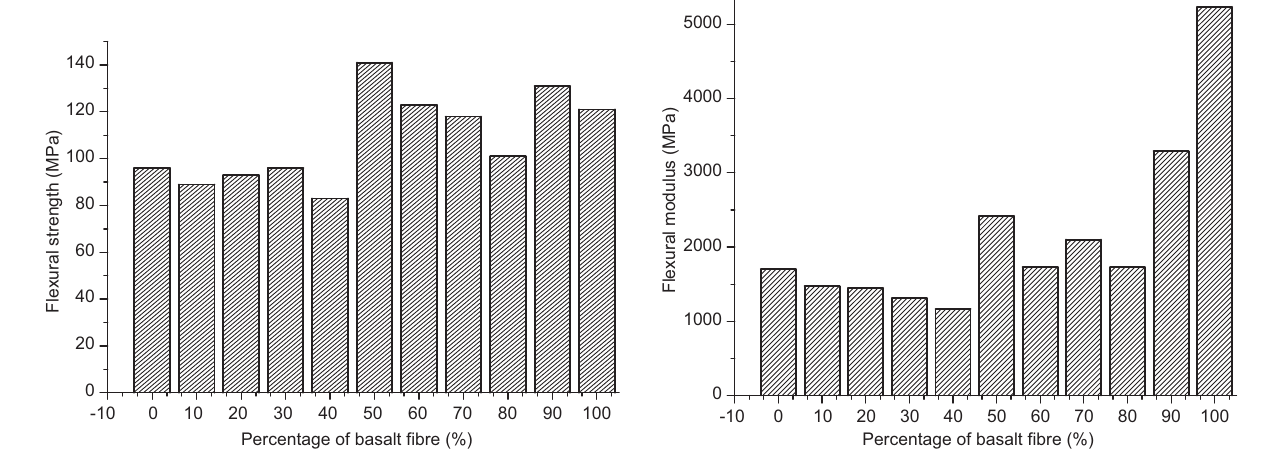
Figure 4 Effect of fiber percentage on flexural strength. Figure 5 Effect of fiber percentage on flexural